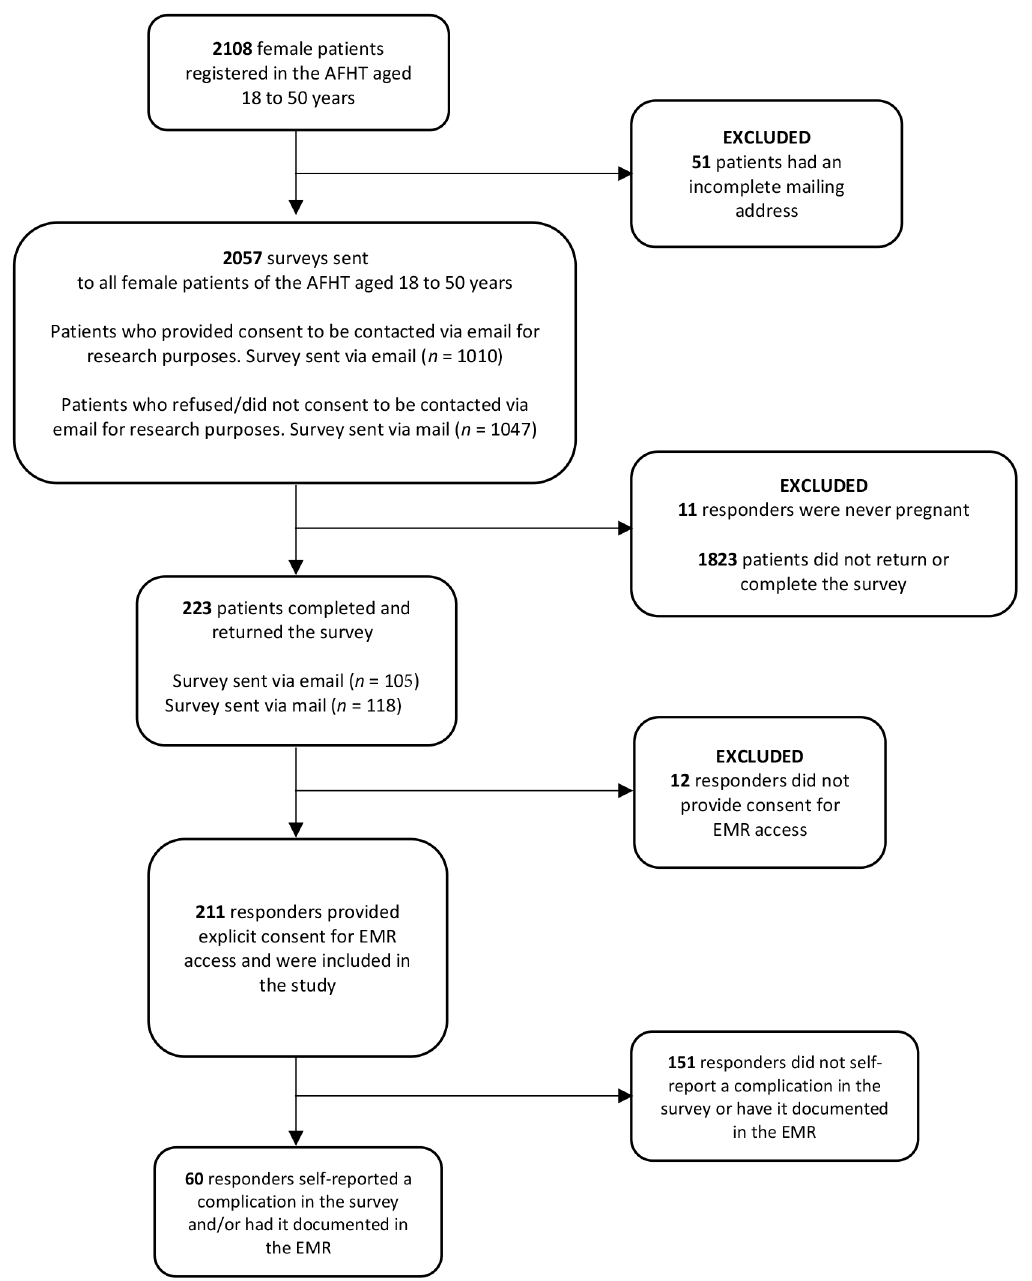
Figure 1 Study participants flowchart. AFHT = academic family health team. EMR = electronic medical